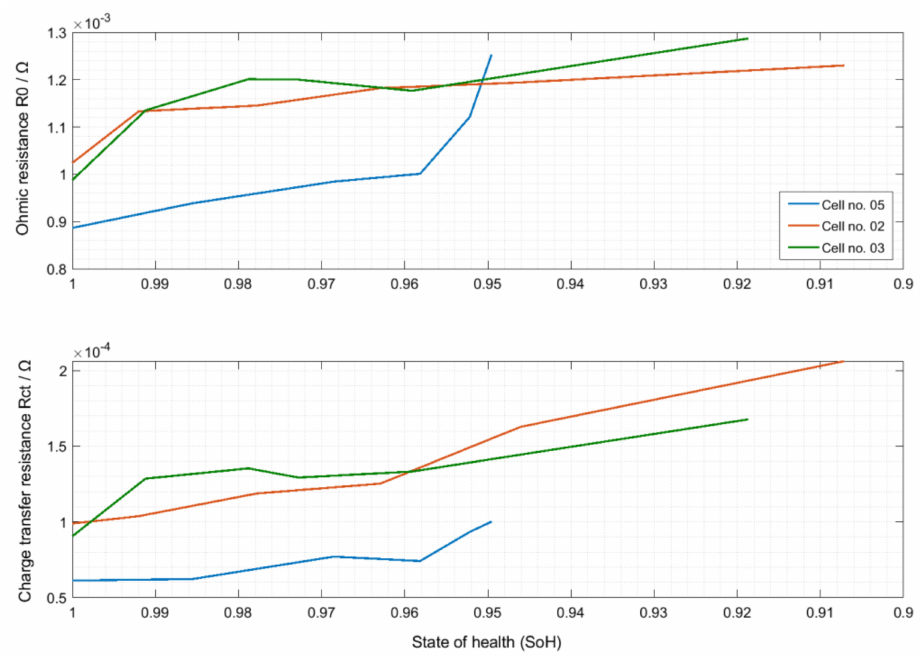
Figure 8. Impedance evolution with respect to